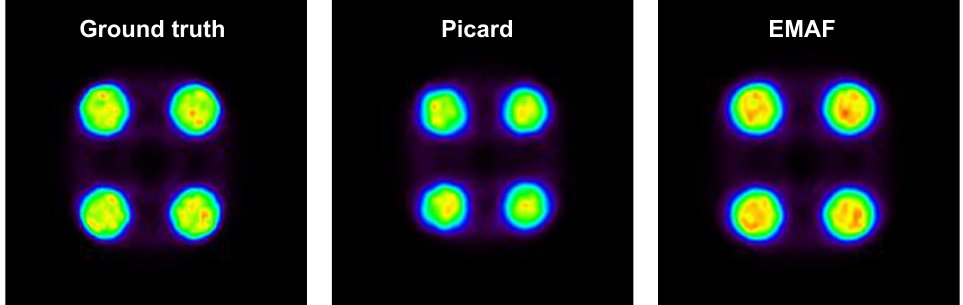
Figure 5. Images of the static (ground truth) image, Picard’s multiple acquisition frame approach (MAF)-corrected image, and enhanced multiple acquisition frames (EMAF)-corrected image.